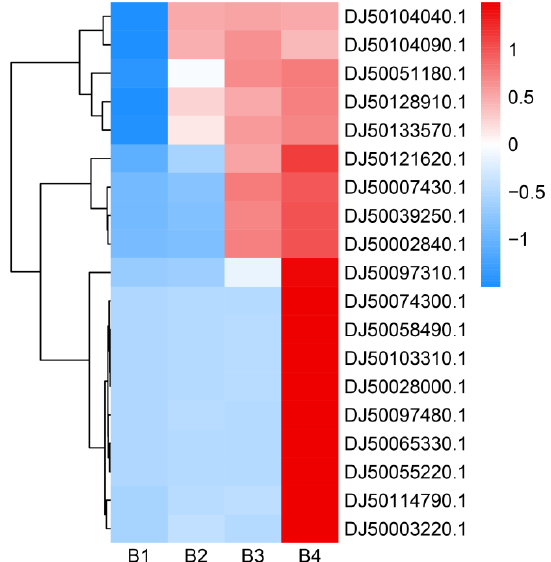
Figure 9. Heatmap analysis of gene expression levels under different light intensities. The right side of the heatmap indicates the gene ID. The FPKM values were transformed to Z-score values. The higher the gene expression level, the higher the Z-score value. The heatmap was drawn and colored in R language (4.2.2) using RStudio (2022.07.02 Build 576).